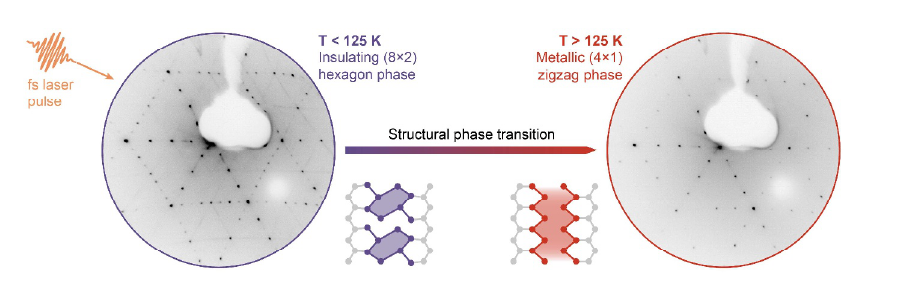
Fig. 3. Diffraction images and structure models of the low-temperature (8×2) and the high- temperature (4×1) phase of Indium atomic wires on a Si(111) surface recorded with 130eV electron pulses in our ULEED setup. The twofold streaks in the diffraction pattern of the (8×2) phase are the result of the missing correlation between adjacent atomic